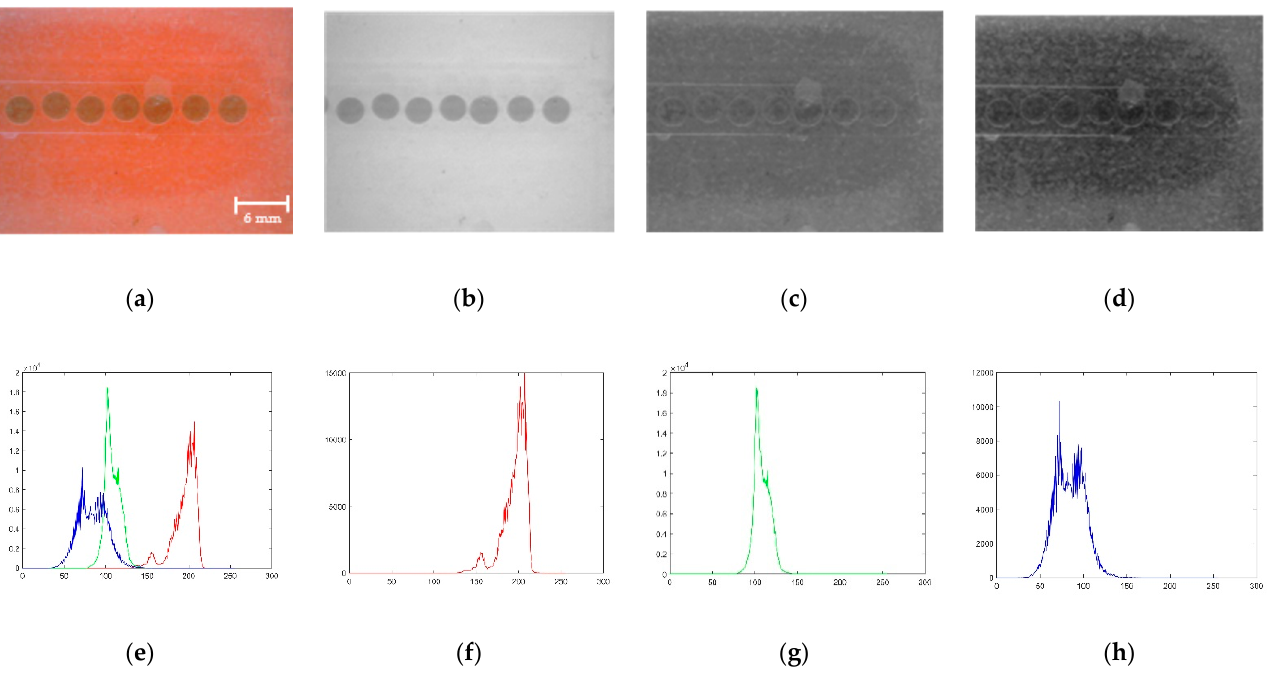
Figure 10. Band filtering: ( a ) Original image; ( b ) Red segment; ( c ) Green segment; ( d ) Blue segment; ( e – h ) Respective histograms.